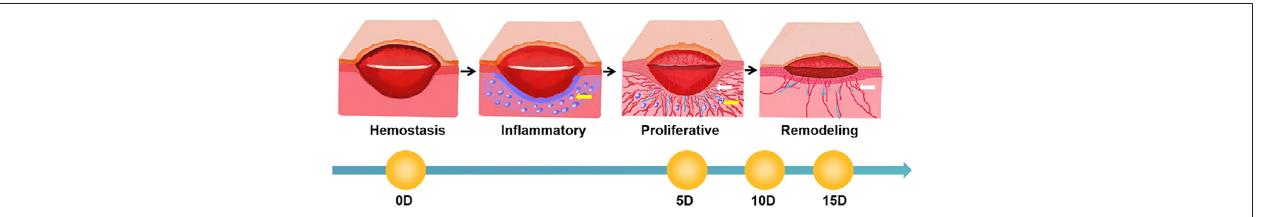
FIGURE 11 | Schematic diagram of the wound healing process (white arrows mark new blood vessels, and blue circles indicated by yellow arrows mark areas of in fl